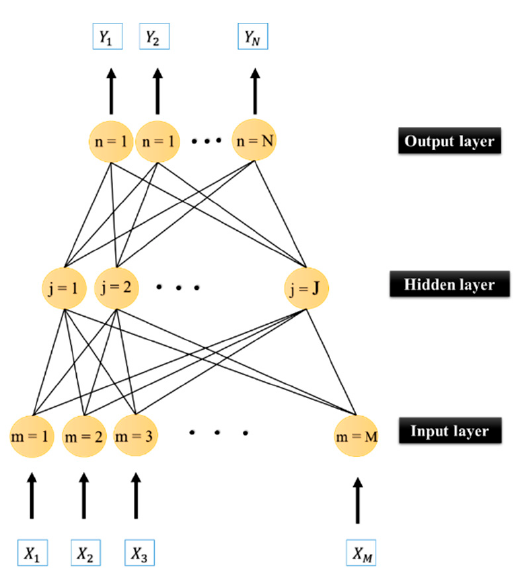
Figure 4. The general structure of the ANN.